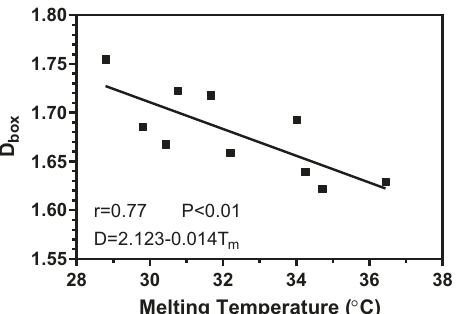
Fig. 4 Global relationship between the box-counting fractal dimension (D box ) of polarized light microscopy images of CB samples and their corresponding melting temperature (T m ). Fractal dimension values plotted represent the means of six images, while melting temperature values plotted represent the means of three